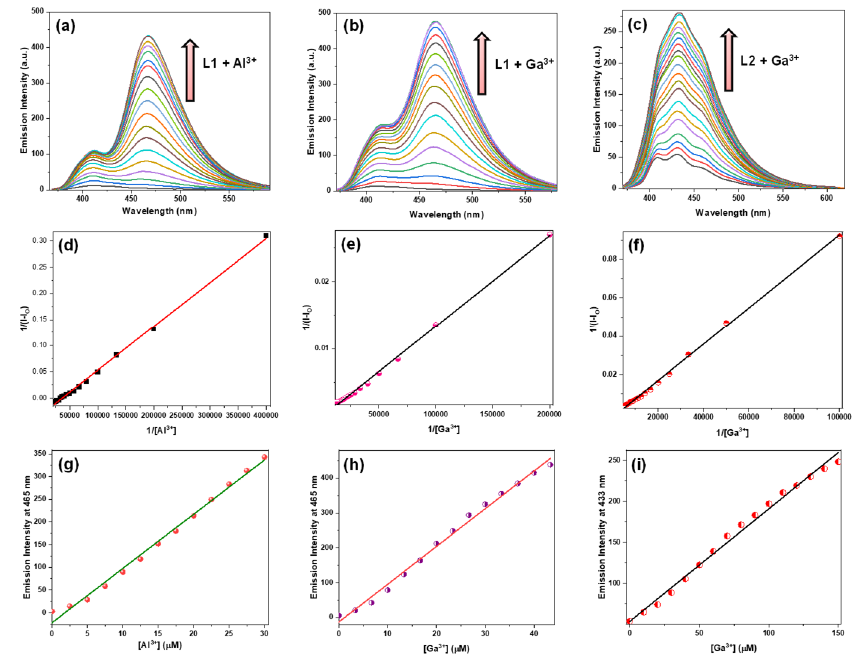
Figure 5 . Change in the emission spectra of L1 (c, 20 μM) on successive addition of ( a ) Al 3+ ion (0-75 μM) and ( b ) Ga 3+ ion (0-75 μM); ( c ) L2 (c, 20 μM) on successive addition of Ga 3+ ion (0-200 μM). Determination of binding constants by Benesi–Hildebrand plots for the detection of ( d ) Al 3+ ion, ( e ) Ga 3+ ion by L1 , and ( f ) Ga 3+ ion by L2 from the emission spectral profiles. Determination of detection limit of L1 towards the ( g ) Al 3+ ion, ( h ) Ga 3+ ion, and ( i ) L2 towards the Ga 3+ ion.